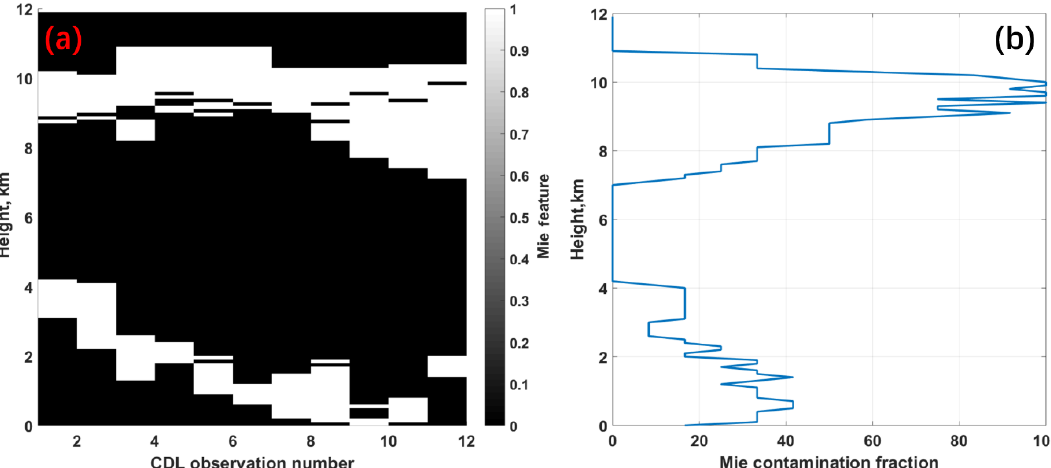
Figure 14. (a) Matched CDL measurement where valid (or invalid) signal is represented as 1 (or 0). (b) Mie contamination fraction, F Mie , of selected datasets from Table 2 used for